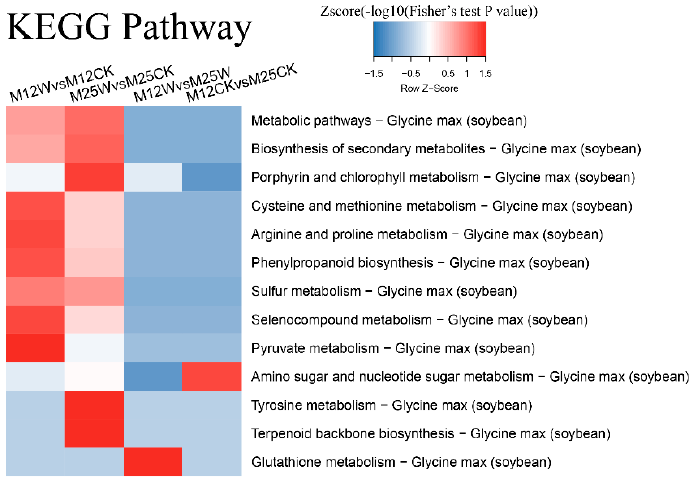
Figure 6. KEGG pathway analysis of differentially abundant proteins in two alfalfa cultivars (M12 and M25) under waterlogged and control conditions. M12CK indicates M12 under control condition; M12W indicates M12 under waterlogged condition; M25CK indicates M25 under control condition; M25W indicates M25 under waterlogged condition.